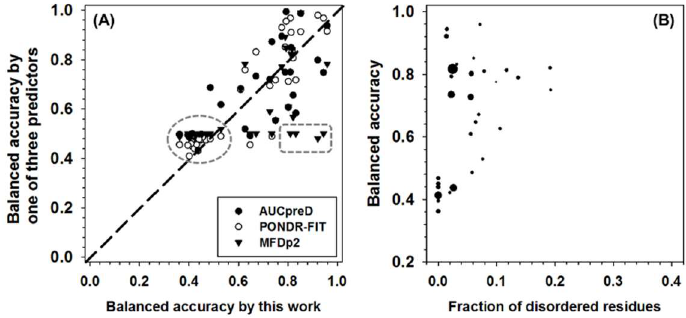
Figure 5. ( A ) Comparison of per-sequence balanced accuracy among AUCpreD (filled circle), PONDR-FIT (open circle), MFDp2 (filled triangle), and this work on sequences in the CASP10 test dataset. The reasons for selecting these predictors are: (1) they are developed in recent years; (2) they have higher performance on some of the accuracy measures; (3) for simplicity of visualization, only four predictors were selected. The x -axis shows the per-sequence balanced accuracy of this work, and the y -axis shows the per-sequence accuracy of the other three predictors. ( B ) Per-sequence balanced accuracy of this work ( y -axis) as a function of the fraction of experimentally validated intrinsically disordered amino acids (IDAAs) ( x -axis). The size of the symbol is proportional to the length of the sequence.